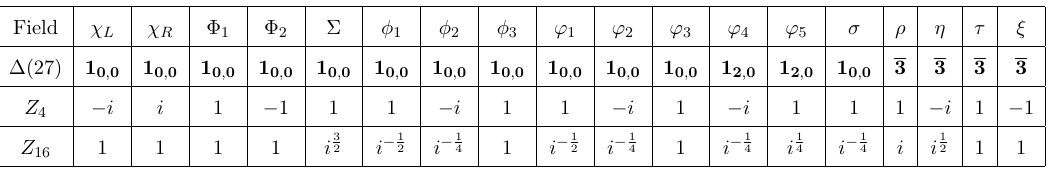
Table 3 . Transformation properties of the scalars under the (cid:13)avor symmetry (cid:1)(27) (cid:10) Z 4 (cid:10) Z 0